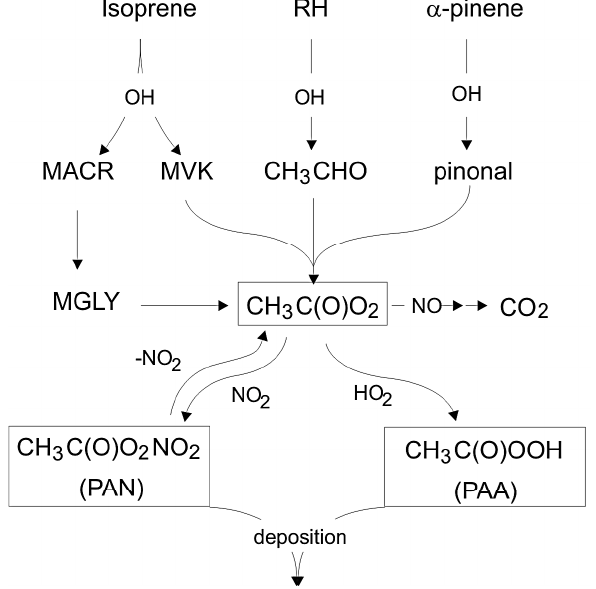
Fig. 1. Exemplary reaction scheme ilustrating the production of the peroxyacetyl radical (PA) from a number of VOC oxidation path-